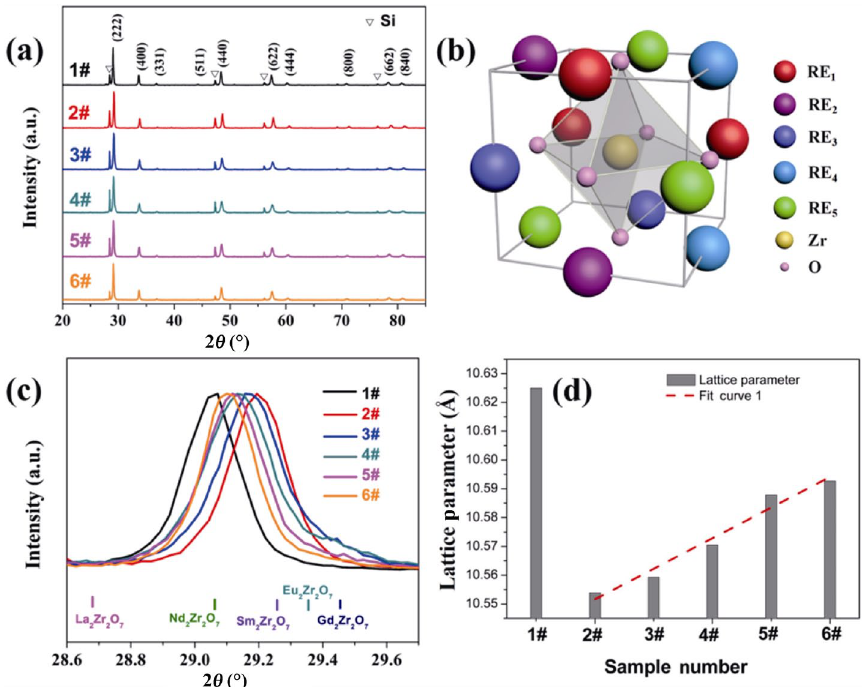
Fig. 2 (a) XRD patterns of the ceramics 1# (La 0.2 Nd 0.2 Sm 0.2 Eu 0.2 Gd 0.2 ) 2 Zr 2 O 7 , 2# (Y 0.2 Nd 0.2 Sm 0.2 Eu 0.2 Gd 0.2 ) 2 Zr 2 O 7 , 3# (La 0.2 Y 0.2 Sm 0.2 Eu 0.2 Gd 0.2 ) 2 Zr 2 O 7 , 4# (La 0.2 Nd 0.2 Y 0.2 Eu 0.2 Gd 0.2 ) 2 Zr 2 O 7 , 5# (La 0.2 Nd 0.2 Sm 0.2 Y 0.2 Gd 0.2 ) 2 Zr 2 O 7 , and 6# (La 0.2 Nd 0.2 Sm 0.2 Eu 0.2 Y 0.2 ) 2 Zr 2 O 7 after sintering at 1500 ℃ for 3 h. (b) One-eighth of the unit cell of the high-entropy pyrochlore structure. (c) Zoom-in view of the (222) diffraction peaks of the sintered ceramics with various compositions. (d) Lattice parameters of the sintered ceramics.